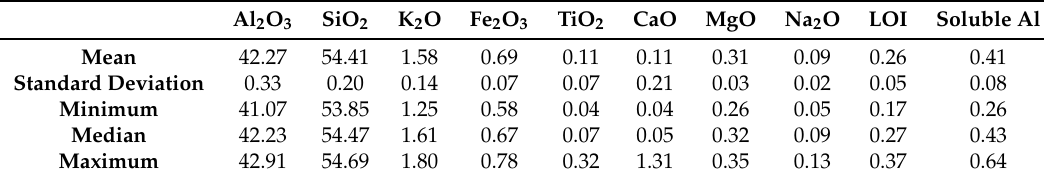
Table 1. Chemical composition determined by X-ray fluorescence (XRF) and the soluble Al 2 O 3 content of the calcined kaolin samples